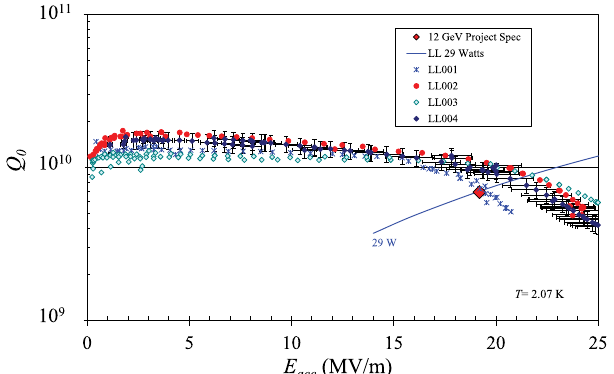
FIG. 26. Qualification tests of the four Low Loss (LL) cavities for Renascence (from